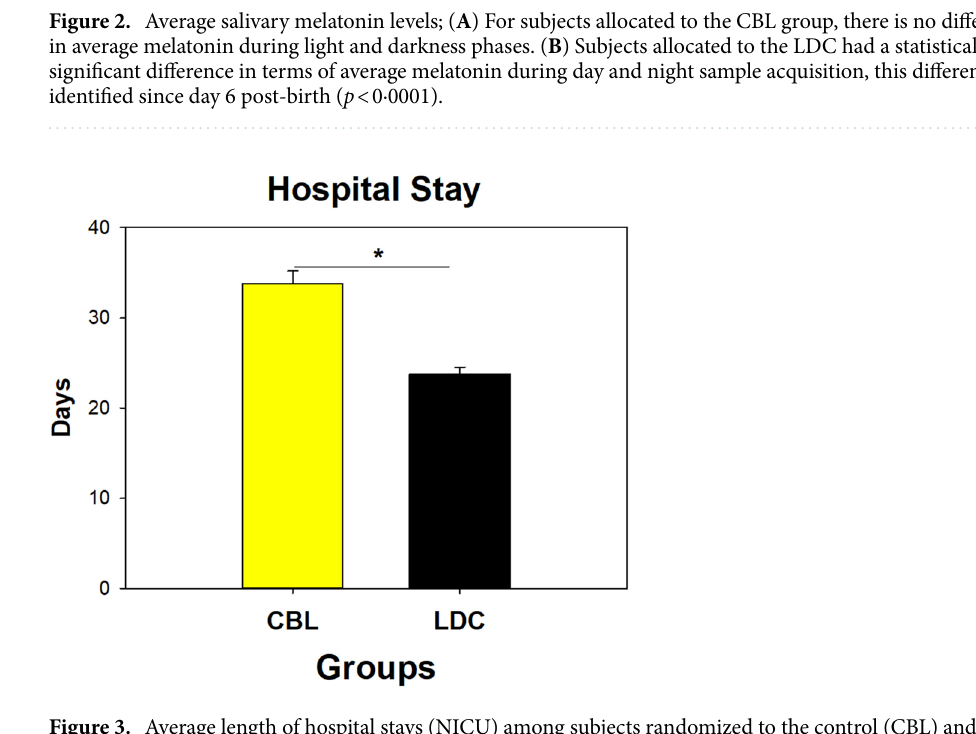
Figure 3. Average length of hospital stays (NICU) among subjects randomized to the control (CBL) and experimental (LDC) study groups. Patients allocated to the control group had a statistically significant prolonged hospital stay (* p <